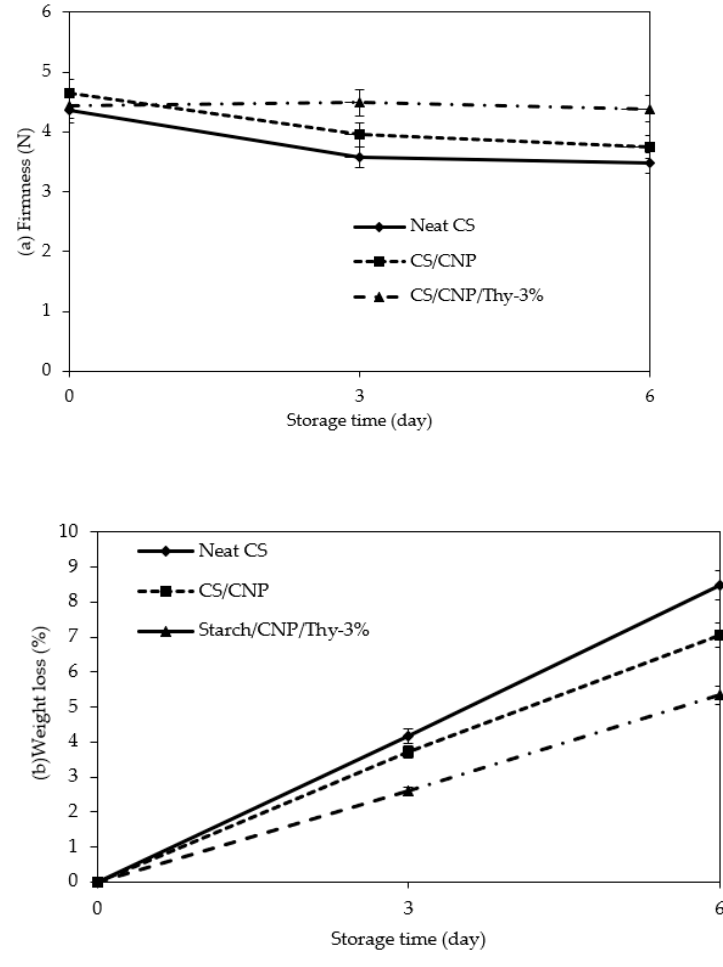
Figure 6. ( a ) Firmness and ( b ) percentage weight loss of cherry tomatoes packaged with neat CS films, CS/CNP bio-nanocomposite films, and CS/CNP/Thy 3% bio-nanocomposite films during 6 days’ storage at ambient condition.